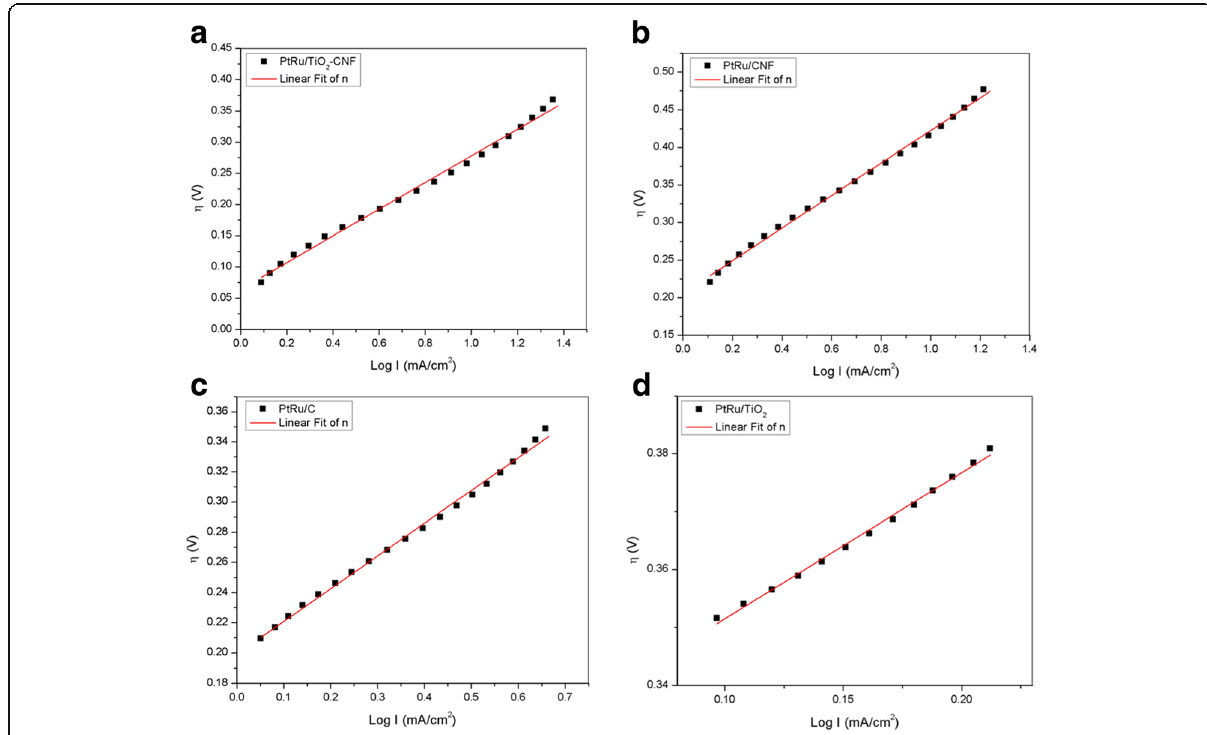
Fig. 6 Tafel plot of the electrocatalyst a PtRu/TiO 2 -CNF, b PtRu/CNF, c PtRu/C, and d PtRu/TiO 2